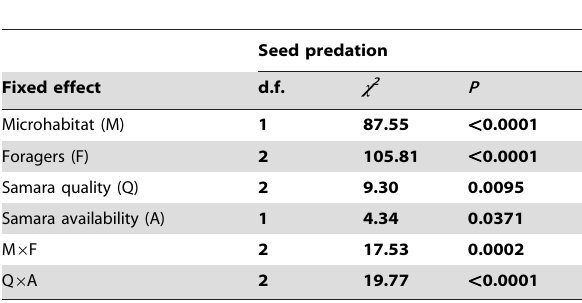
Table 1. Summary of the Wald x 2 -test for the GLMM to analyze the factors affecting seed predation (proportion of full samaras predated in each